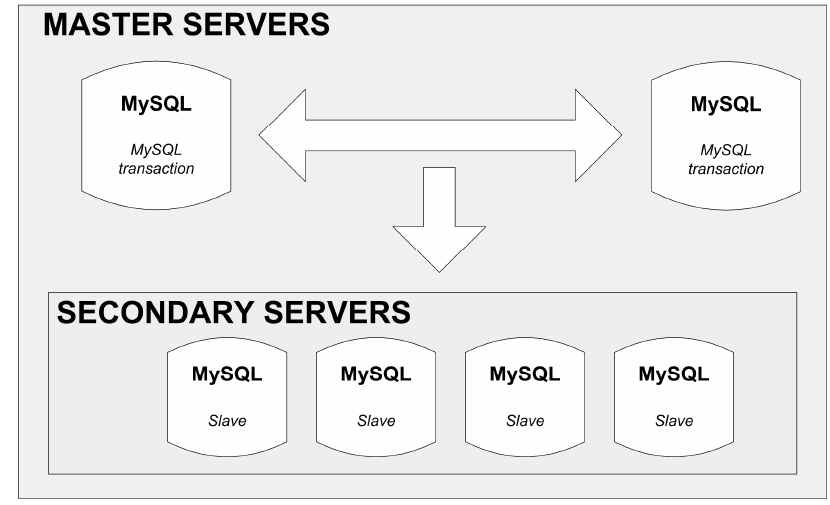
Figure 6. An example solution for the Web cluster.